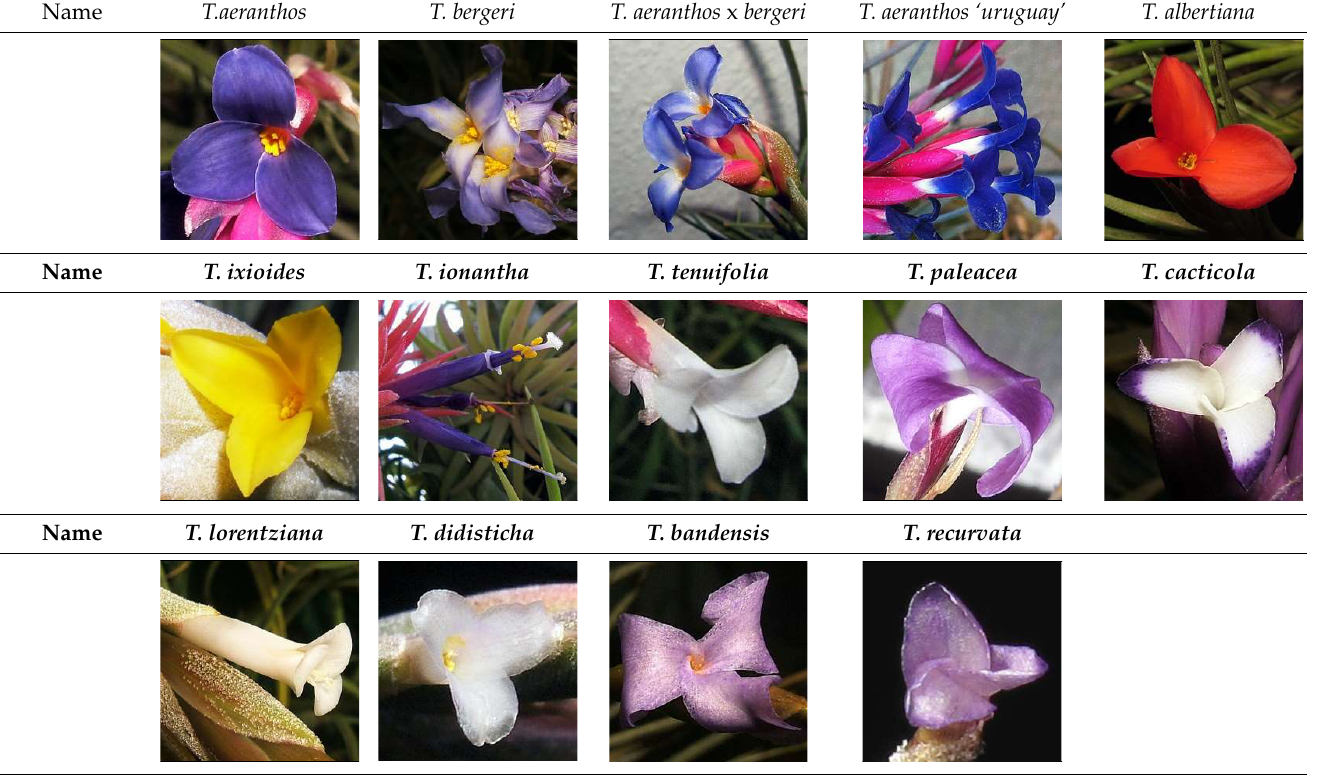
Table 1. Flowers of the 14 Tillandsia species studied. © Julien Vigo for the photographs.